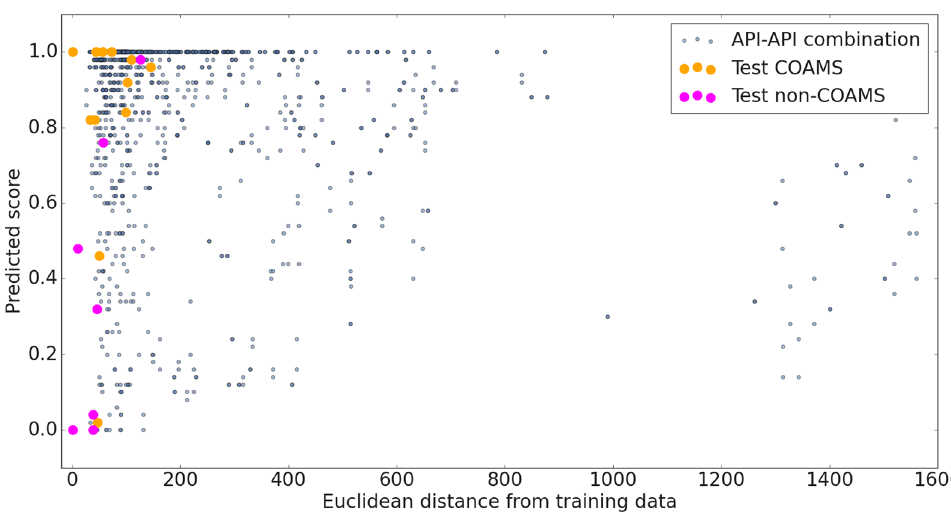
Figure 5. Graphical description of the predictions for the test data and all new API-API combinations. Vertically, the average of the predicted class (1 = COAMS, 0 = non-COAMS) from 50 ML models is depicted, horizontally, the distance from the original training data.